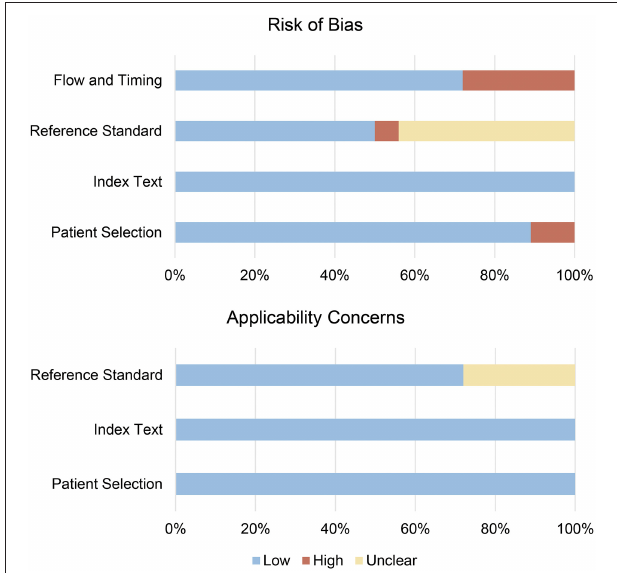
FIGURE 2 | Risk of bias summary for included studies. The methodological quality of included studies was assessed with the revised Quality Assessment of Diagnostic Accuracy Studies (QUADAS-2) tool. This tool comprises four domains: patient selection, index test, reference standard, and flow and timing. Each domain is assessed in terms of risk of bias, and the first three domains are also assessed in terms of concerns regarding